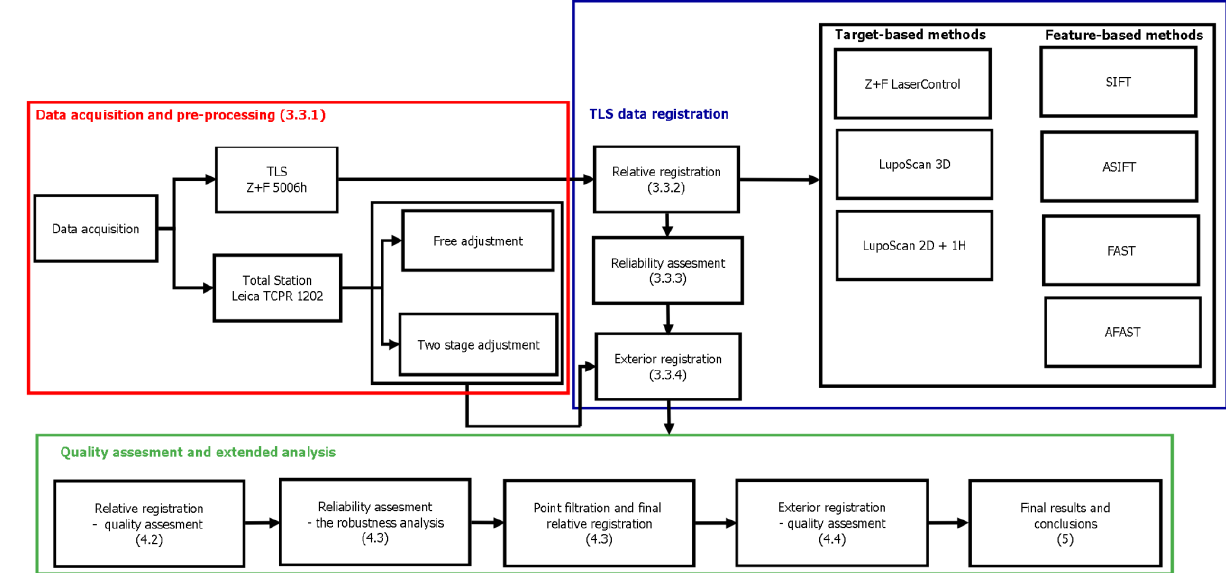
Figure 3. Diagram of the performed experiments: data acquisition, processing and analysis.